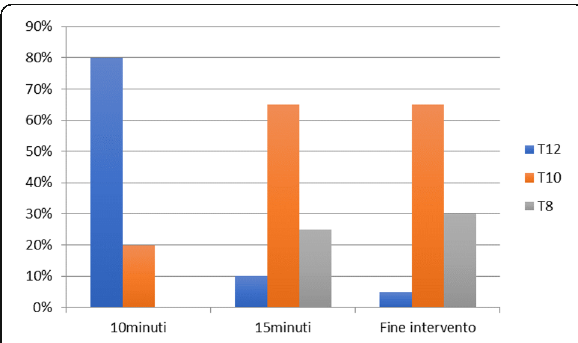
Fig. 1 (abstract A52). Sensitive block onset and